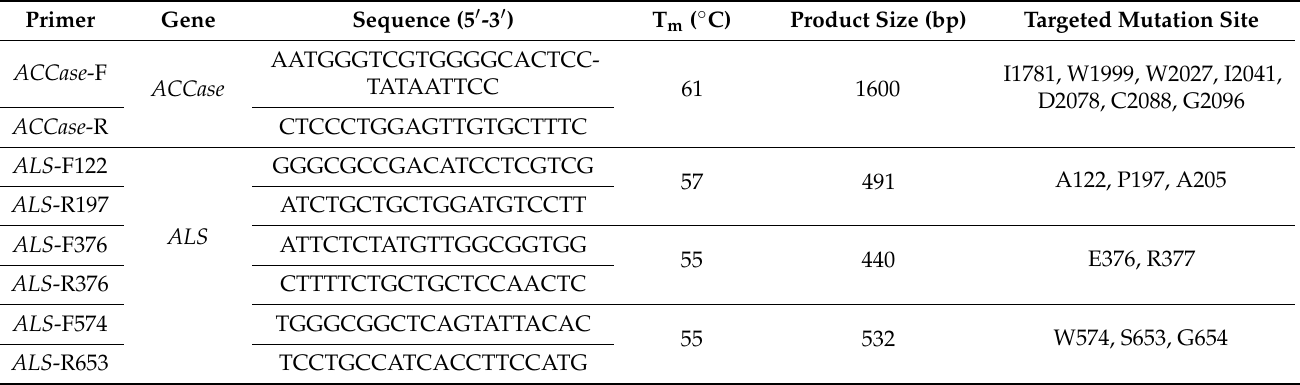
Table 3. Primers used for ACCase and ALS sequencing in different L. multiflorum